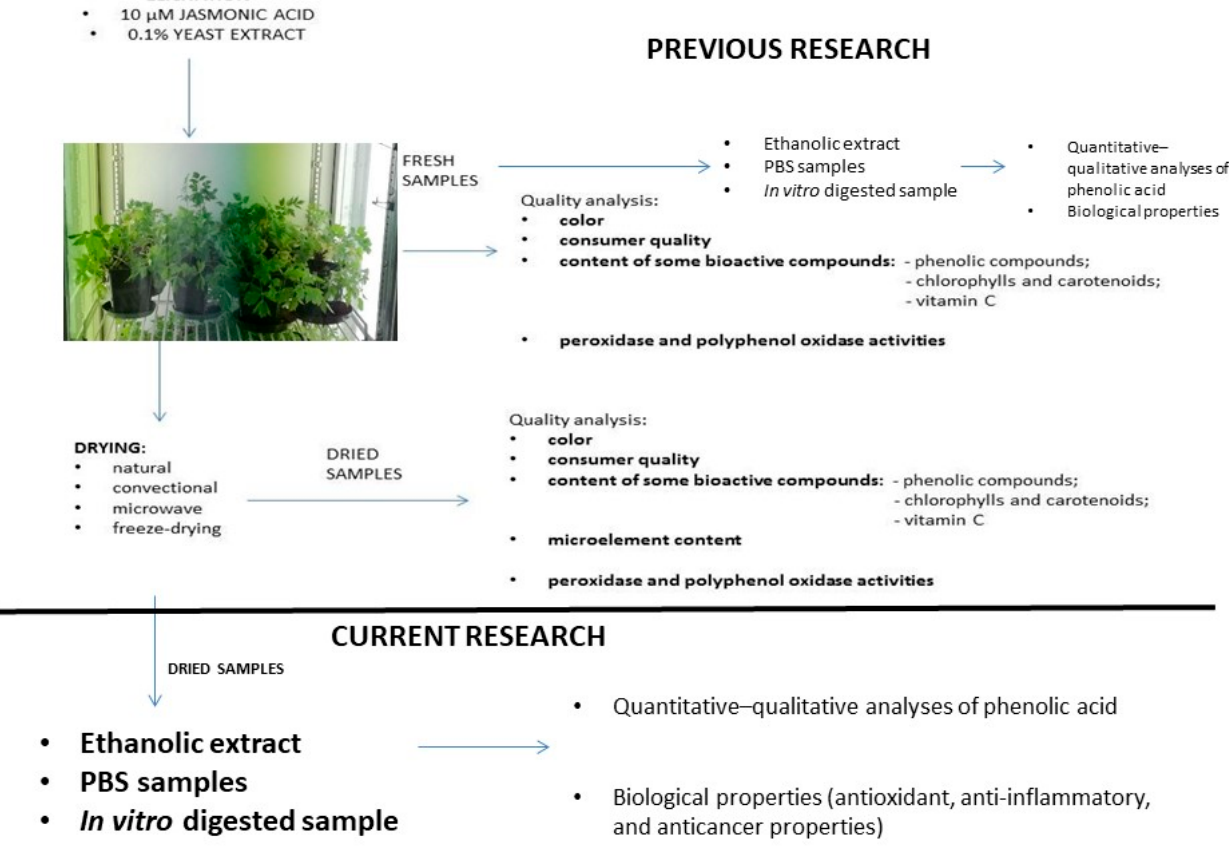
Figure 1. Scheme of the experimental procedure.